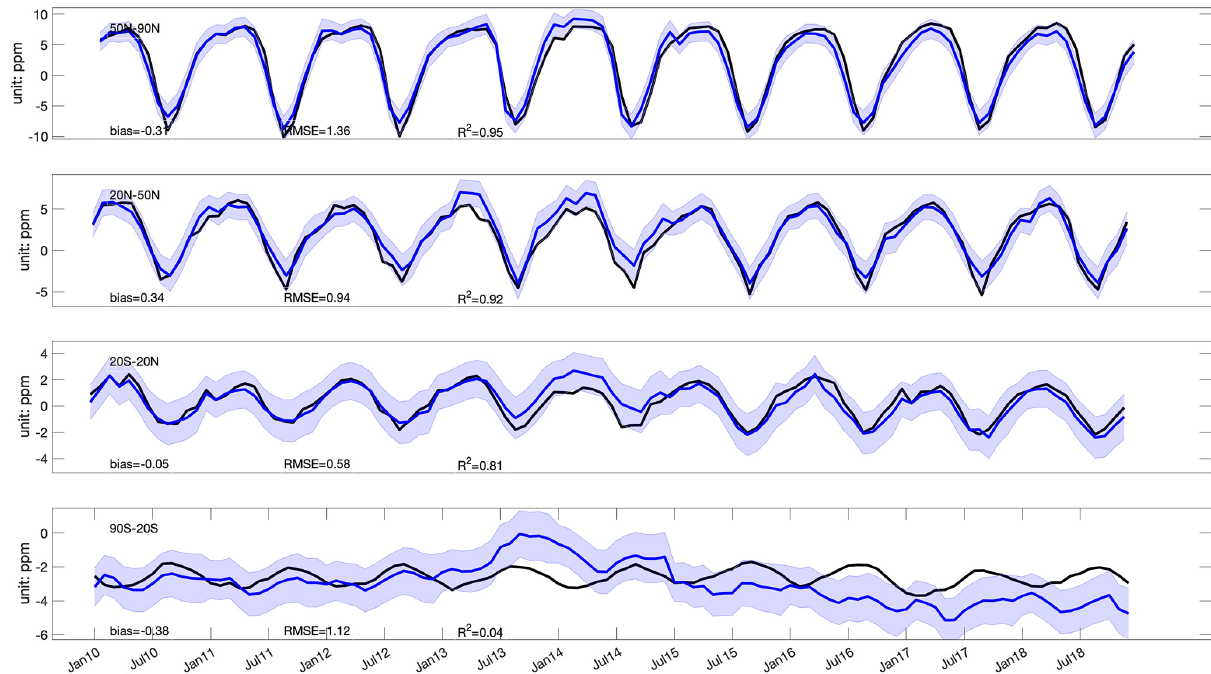
Figure 12. Comparison between posterior CO 2 and the NOAA marine boundary layer (MBL) reference sites. Black: observations averaged over each latitude band; blue and shaded area: posterior CO 2 and its uncertainty. The global mean CO 2 (https://www.esrl.noaa.gov/gmd/ccgg/ trends/global.html, last access: 29 May 2020) was subtracted from both the NOAA MBL reference and posterior CO 2 before the